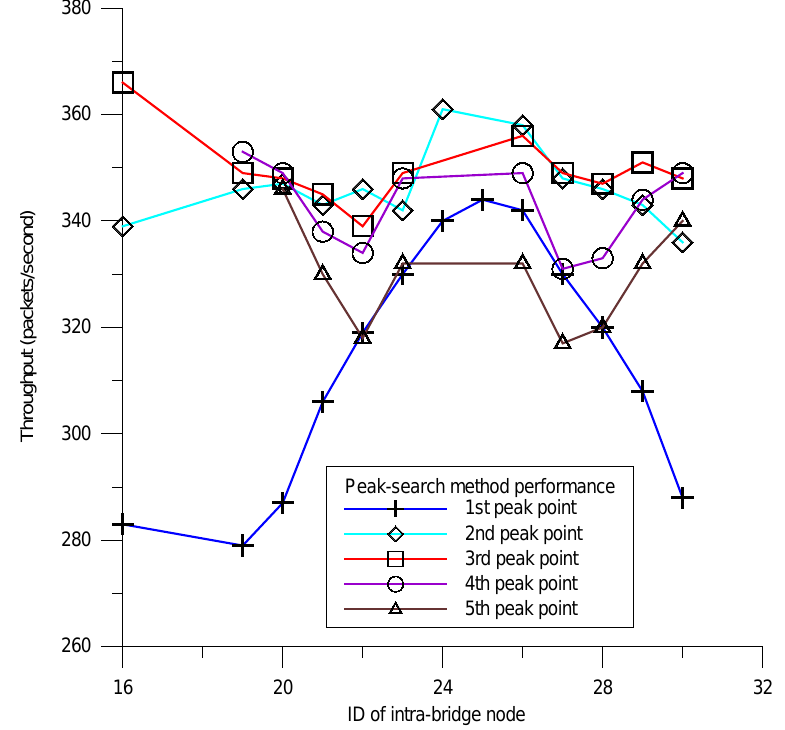
Figure 7. The determined bridge node with highest throughput of peak search method for piconet case.